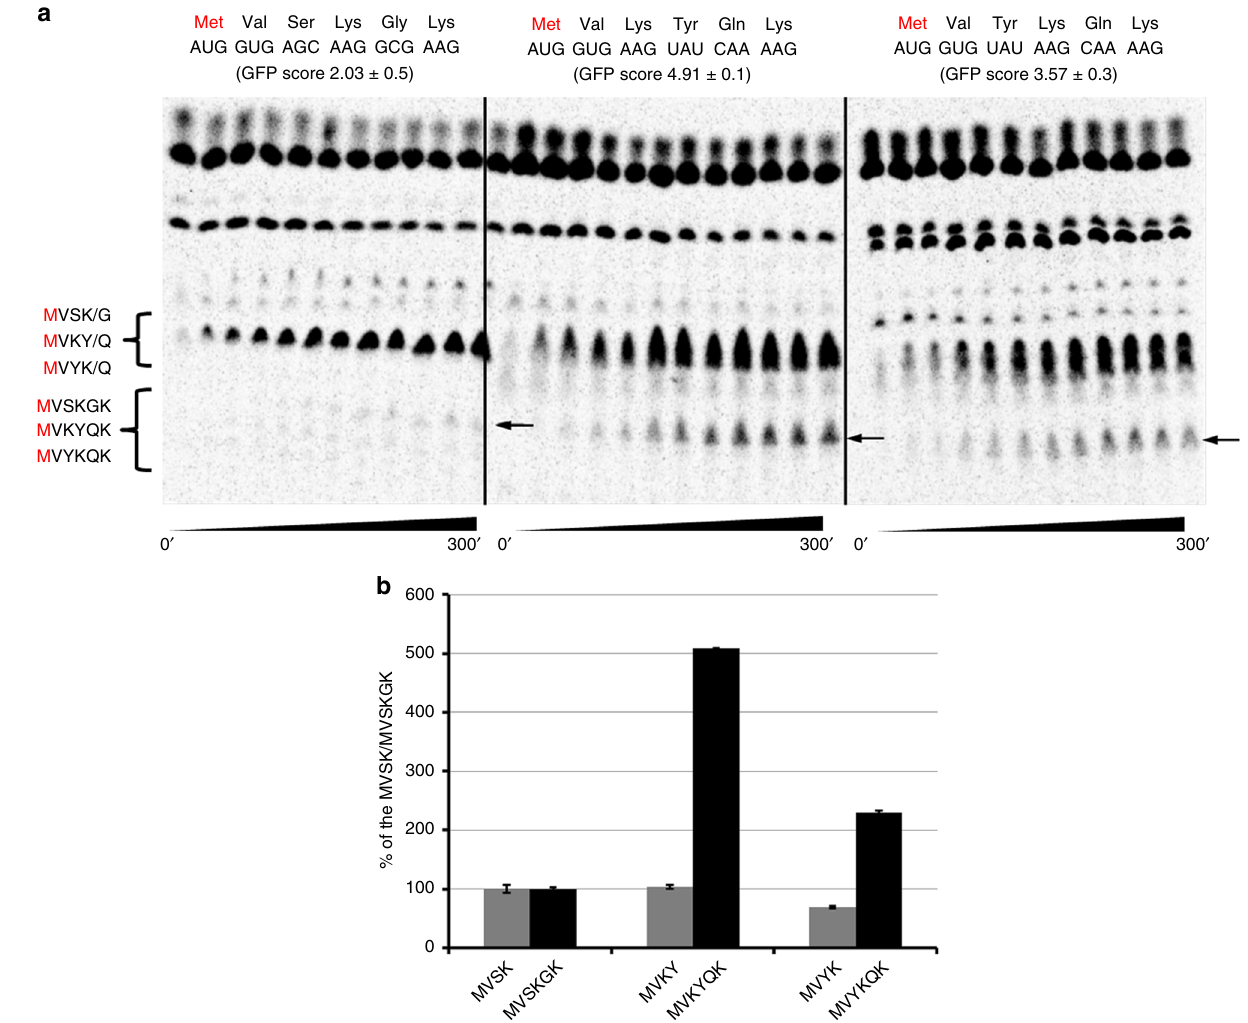
Fig. 6 The identity of the fi rst 5 amino acids impacts protein synthesis in a well-de fi ned in vitro translation system. a Thin-layer chromatography (TLC) analysis of in vitro peptide synthesis using S35-labeled methionine (M in red). Sequences and GFP scores of tetra-peptides, penta-peptides, and hexa- peptides representing starts of wild type eGFP (MVSKGK) and two high expressing clones MVKYH and MVYKH are indicated. Protein synthesis was initiated from pelleted initiation complexes at time 0 and resolved over time (300 s). Points at 1, 5, 10, 20, 30, 45, 60, 90, 120, 180, 240, 300 s are shown. Migration of tetra-peptide, penta-peptide, and hexa-peptide is indicated. Arrows indicate fi nal hexa-peptide products of the reaction. b Analyses of accumulation of the tetra-peptide and hexa-peptide for MVSKGK, MVKYHK, and MVYKHK peptides. Amounts of radioactivity for tetra-peptide and hexa- peptide for the last three time points (180 – 300 s) were normalized to total radioactivity and plotted in relation to MVSK or MVSKGK peptide amounts. Error bars represent standard